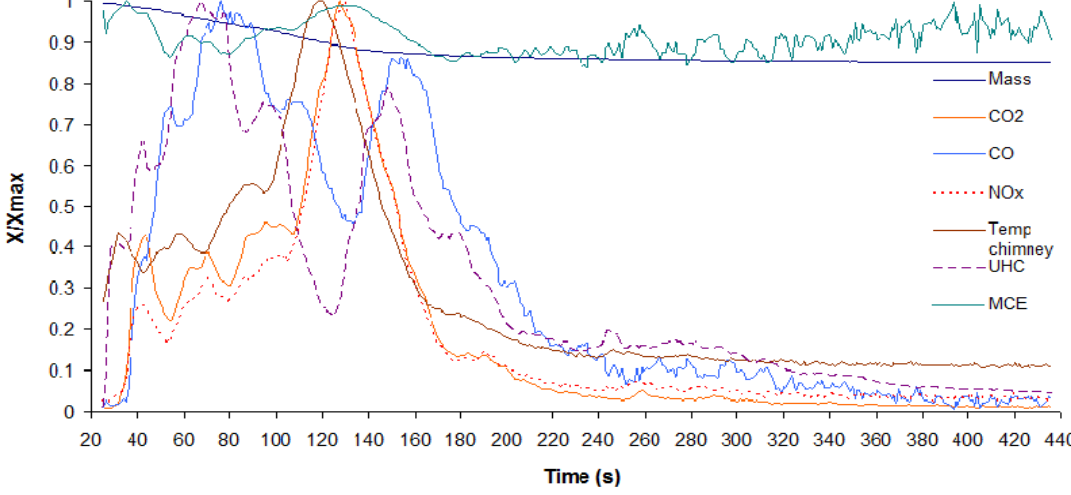
Figure 3. Observed pattern of the combustion process of the sample with the greatest registered humidity content. Normalized data, as a function of time: gas emissions and their relation with the combustion